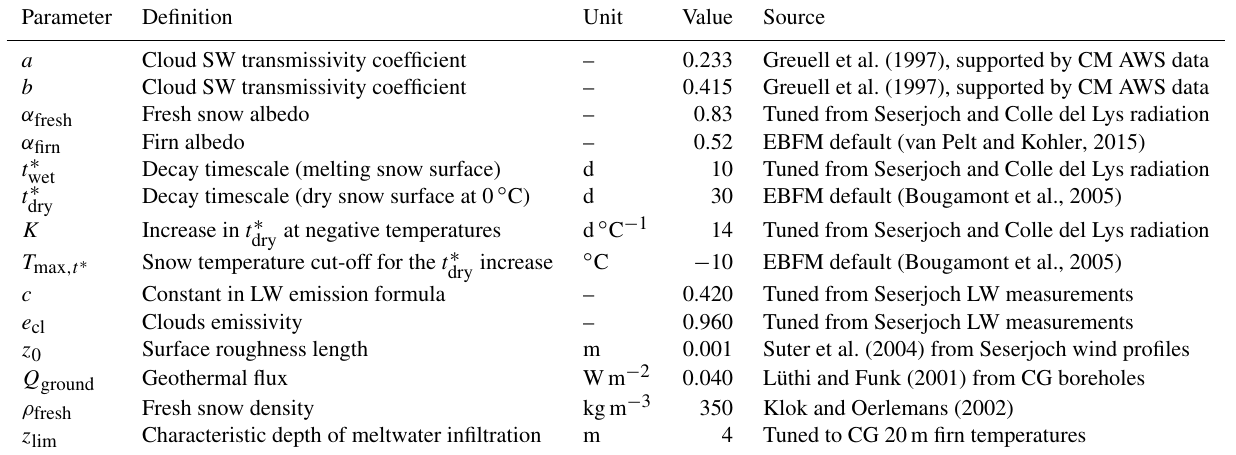
Table 5. EBFM parameters considered for calibration. Additional model parameters were kept at the default value (van Pelt et al., 2012; van Pelt and Kohler, 2015; van Pelt et al., 2019) and are listed in the